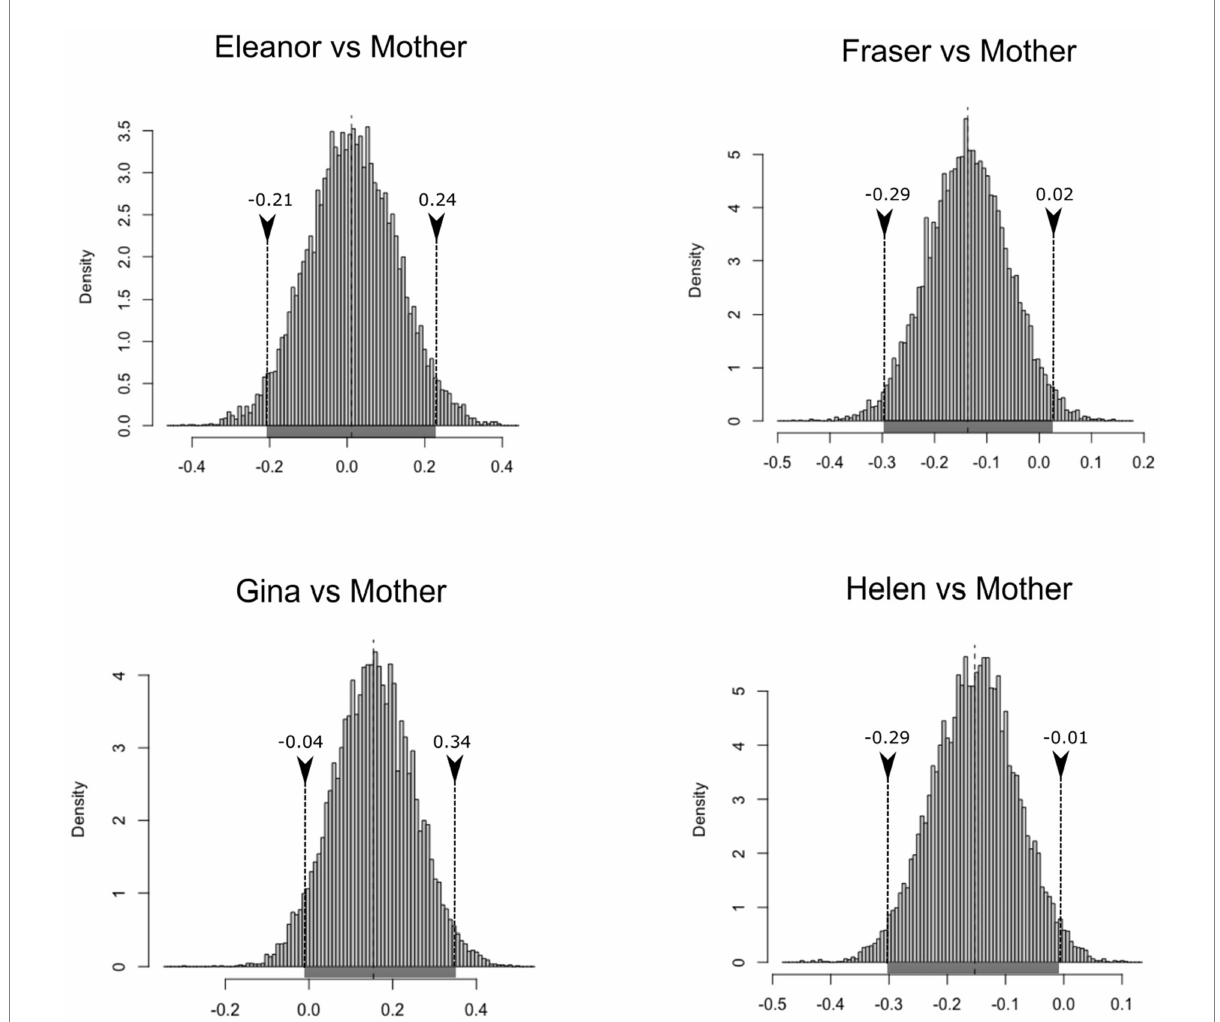
FIGURE 3 Histogram of the bootstrapped replicates of the differences in inflections per verb between the parental and child speech in